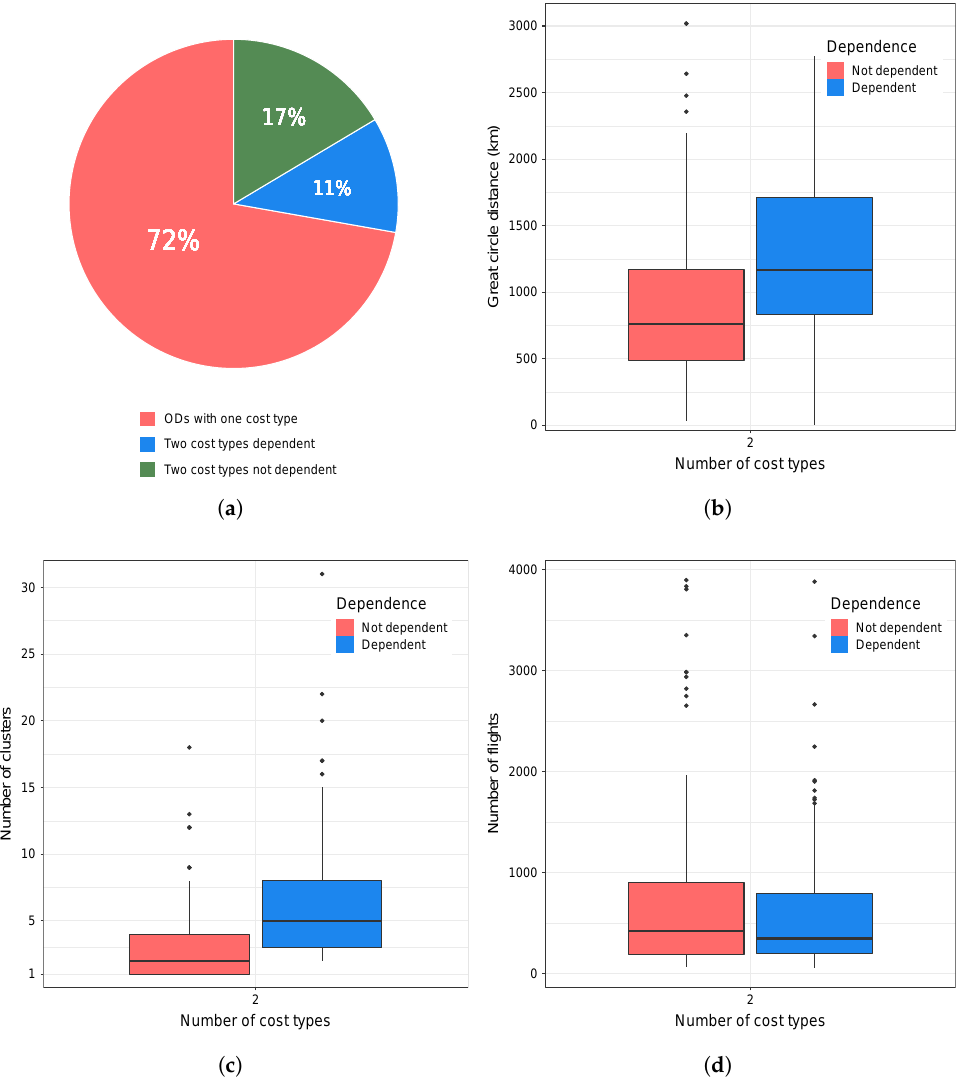
Figure 11. Depiction of the dependence between the cost types and trajectory clusters, and their distribution across number of flights and GCD between ODs. ( a ) number of OD pairs with one or two cost types, showing dependence; ( b ) GCD vs. number of cost types; ( c ) cost types vs. number of clusters; ( d ) cost types vs. number of